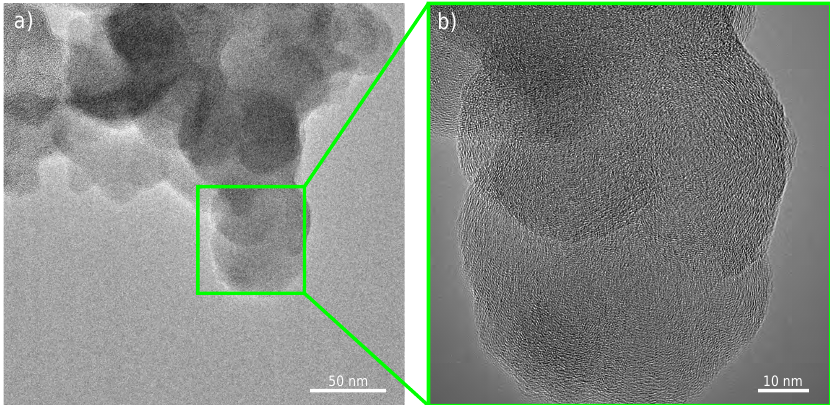
Figure A11. TEM images for PrintexL at ( a ) low magnification and ( b ) high magnification.